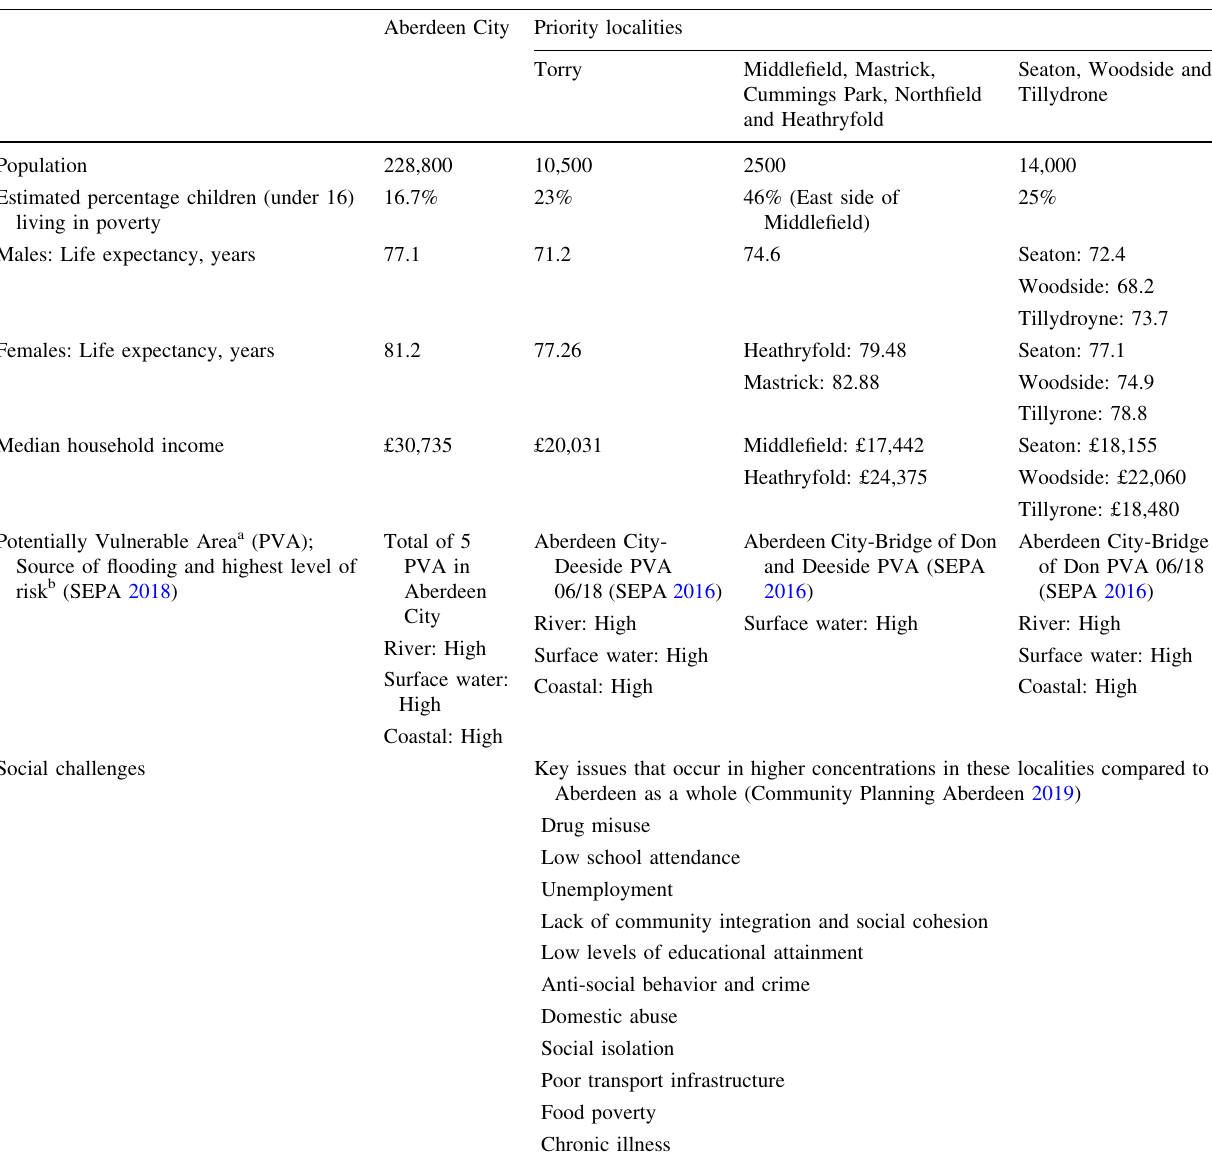
Table 1 Localities identified by Community Planning Aberdeen (2019) for which Aberdeen LRPG has